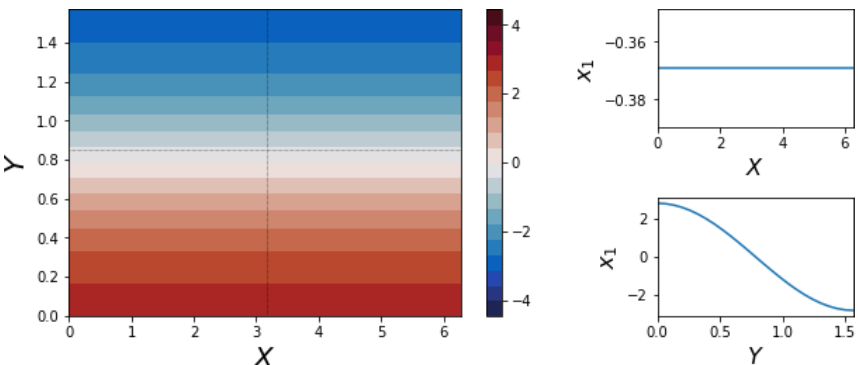
https://doi.org/10.5194/npg-30-49-2023 Nonlin. Processes Geophys., 30, 49–62,